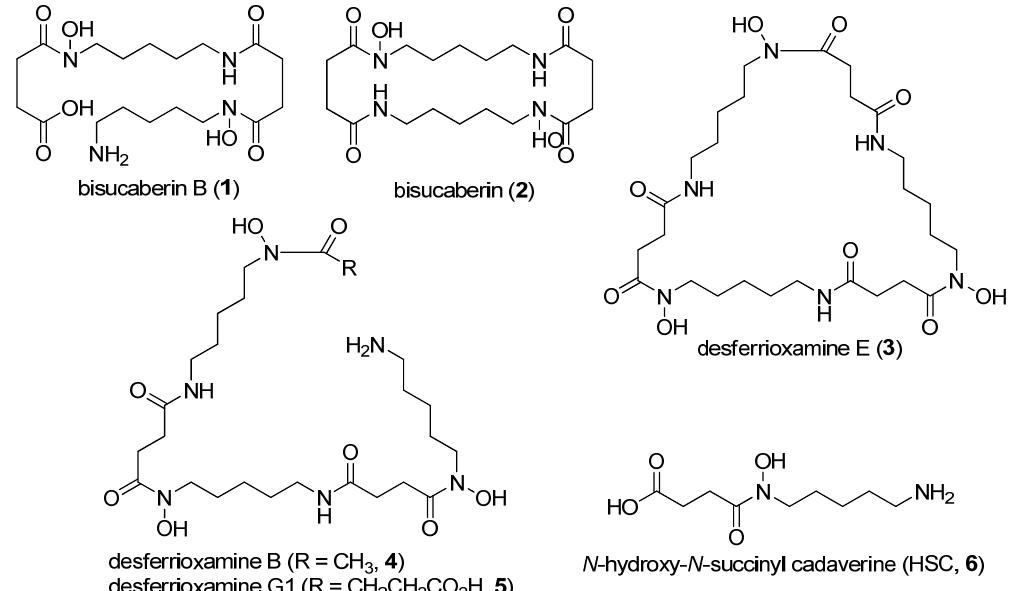
Figure 1. Macrocyclic and acyclic N -hydroxy- N -succinyl cadaverine (HSC) based siderophores and their common monomer